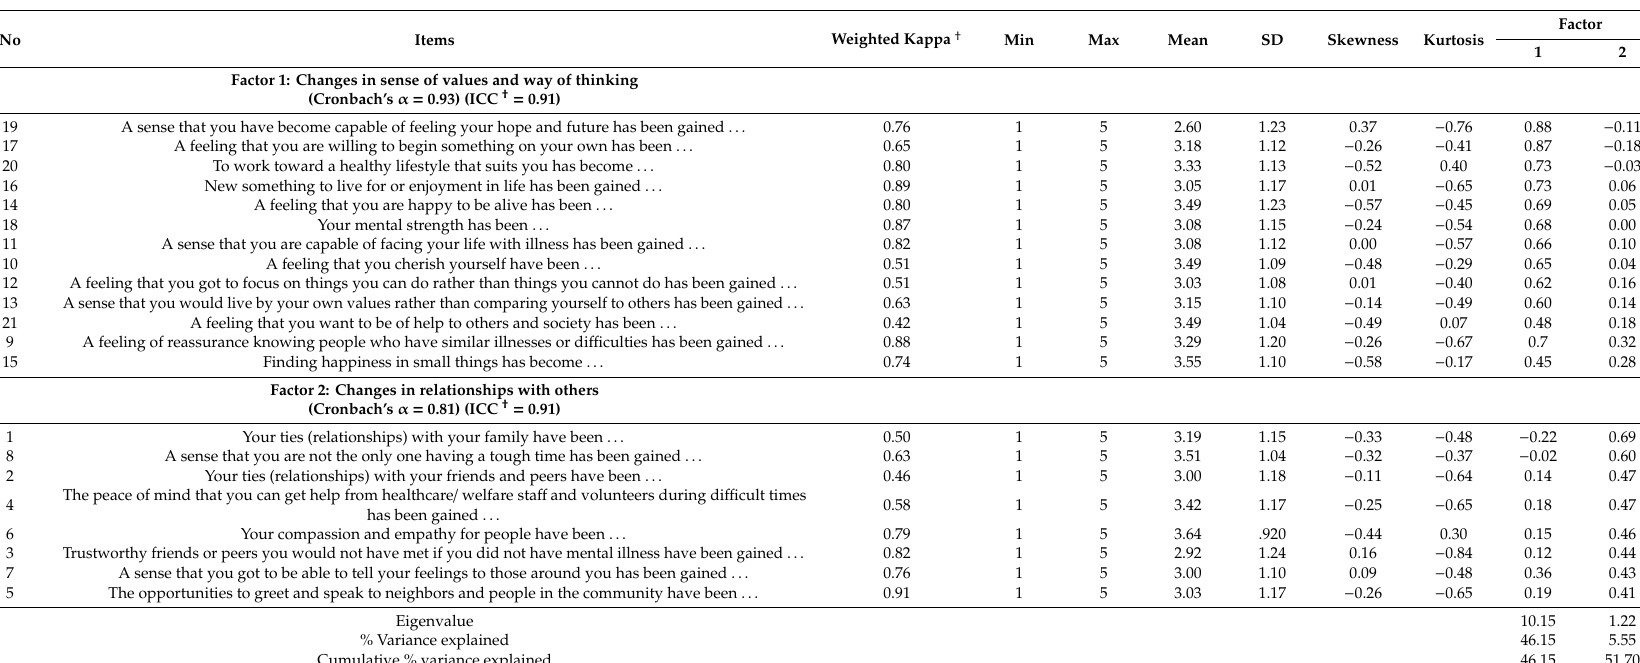
Table 2. Reliability and factors derived from the benefit finding questionnaire (BFQ) ( N = 265): An item factor analysis with the unweighted least squares method and promax